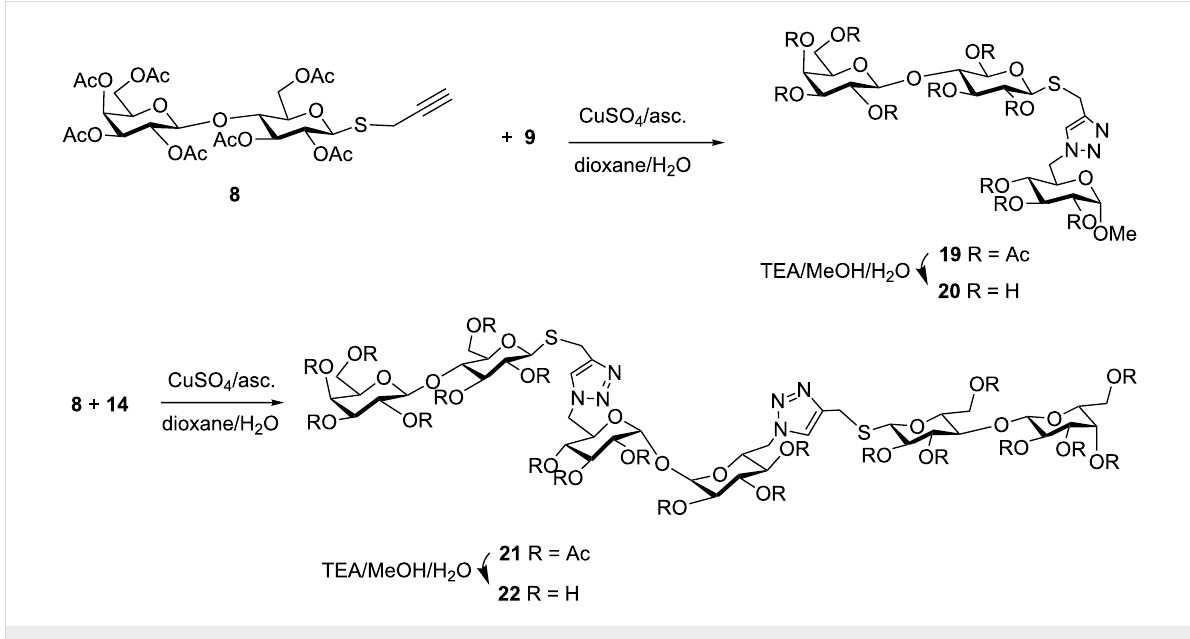
Scheme 3: Synthesis of the mono- and di- S -lactosides.